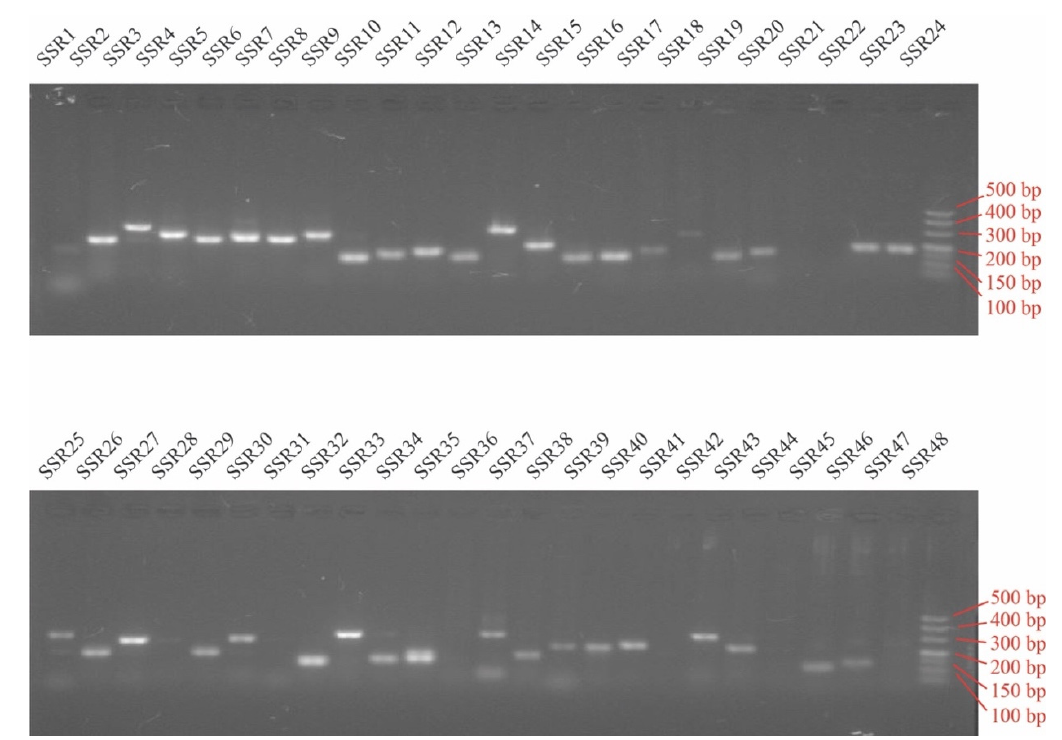
Figure 6. Amplification of 48 SSR primers using genomic DNA of P. edulis as template. Table 2. Genetic diversity analysis with polymorphism SSR markers developed in this study.